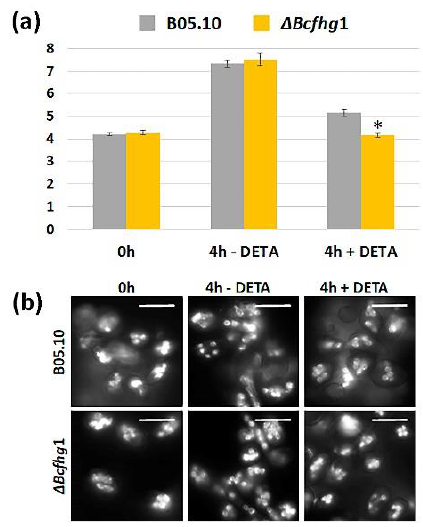
Figure 4. Effect of NO on nuclear division in B. cinerea germinating spores. ( a ) Histogram showing the average number of nuclei in conidia of the B05.10 and Δ Bcfhg 1 strains incubated in static culture in PDB 1/2 during 4 h in the absence and in the presence of 250 µM DETA. The data present the means of three replicates ± SD ( n ≥ 100 each). (* indicates significant differences at p < 0.05—Student’s t -test—in the presence of DETA in the Δ Bcfhg 1 strain in comparison with the B05.10 strain.) ( b ) Representative images of DAPI staining preparations of spores of the B05.10 strain and the Δ Bcfhg 1 mutant strain at the time points and conditions considered in ( a ). As the reference, spores of each strain collected at 0 h were analyzed. Scale bars, 10 µm.